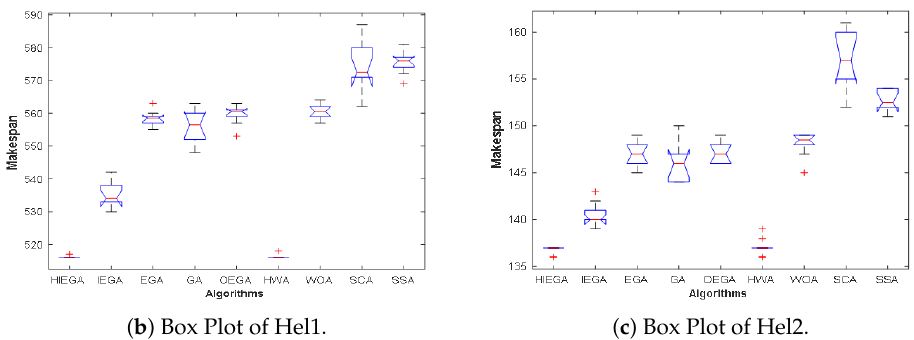
Figure 7. Comparison among algorithms under CPU time and Box-plot for the makespan on the Heller